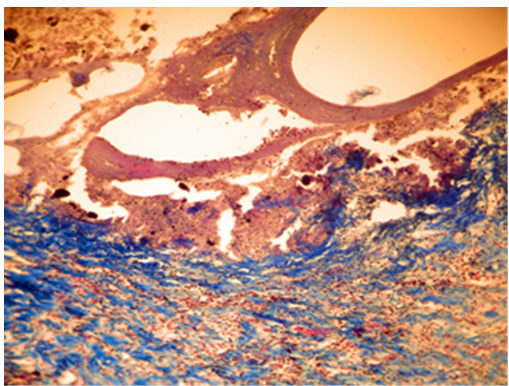
Figure 9. Group C. Moderate necrosis area with pieces of implanted material and moderate leukocyte influx. Partial resorption of the implant material. Subcutaneous tissue—7 days after implant. Col. Trichrome Masson, ×100 .